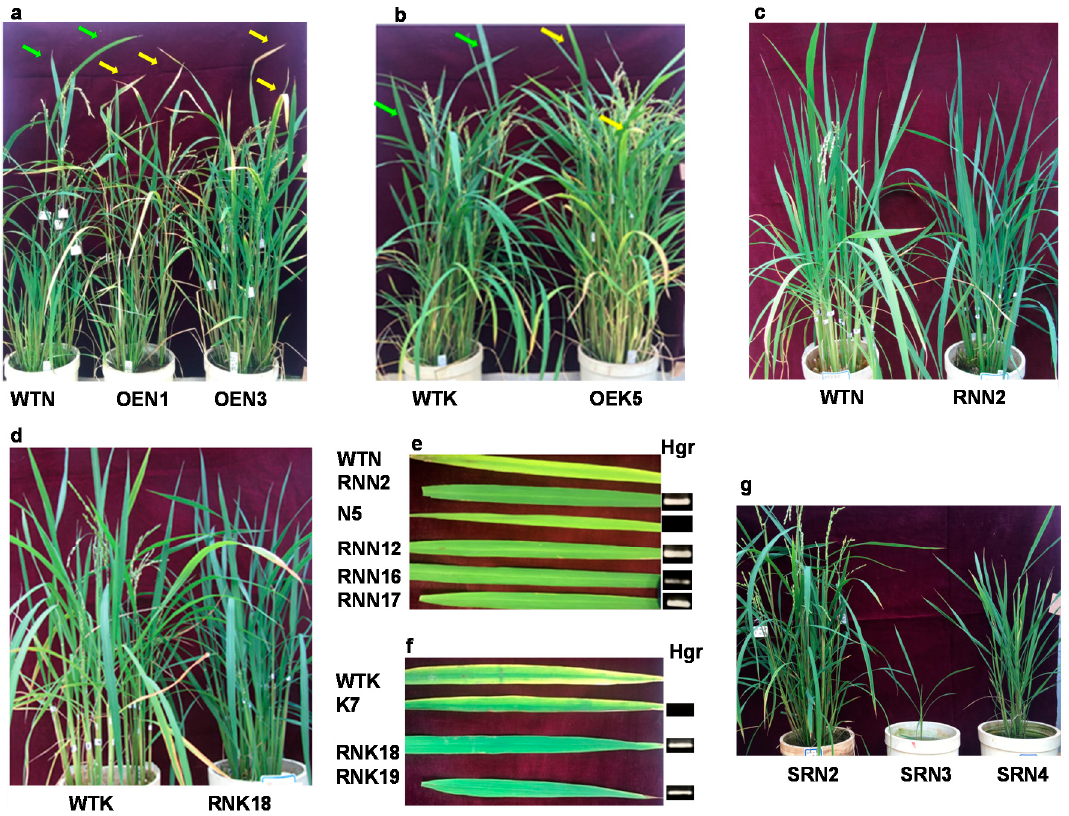
Figure 5. Phenotype of rice plants during senescence. Wild-type and OE lines of Nipponbare ( a ) and Kinmaze ( b ) at 20 days after heading of wild-type Nipponbare and Kinmaze plants. Green arrows indicate wild-type flag leaves showing greenish in color, while yellow arrows depict OE lines with yellowing color. Wild-type and RNAi lines of Nipponbare ( c ) and Kinmaze ( d ) at 15 days after heading of wild-type. Color development of flag leaves of RNAi lines at 70 days after heading of wild-type plants ( e ). Lines N5 (Nipponbare) and K7 (Kinmaze) are Hgr − segregates from the primary T0 transformants of RNN5 and RNK7 respectively. Absence of transgene was verified by PCR (polymerase chain reaction) of genomic DNA by using Hgr-specific primers, hph1 and hph2 ( e , f , Table 1). SRDX lines of Nipponbare at 20 days after heading of wild-type ( g ). Names of plant lines are shown in Figure 4.